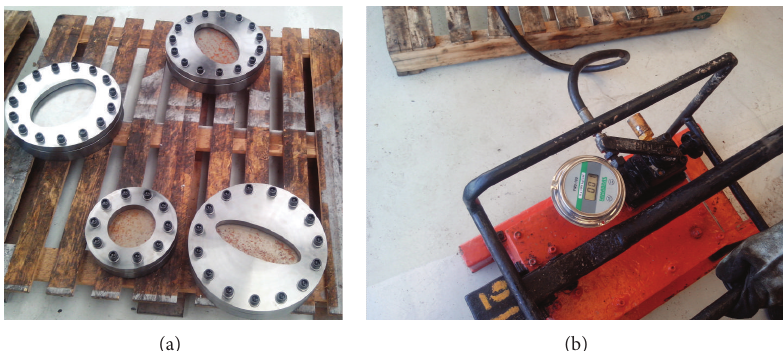
Figure 16: (a) Tools to validate the FEM analysis of the bulge tests. (b) Manual hydraulic pump developed by Rudloff Industrial.